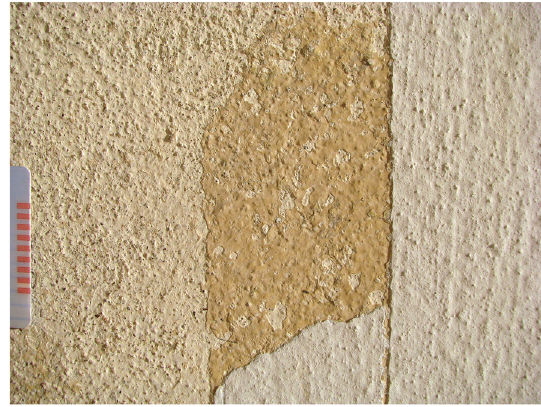
Fig. 9 Tugendhat House, Brno, 1930, view to the southeast, detail: probe during the removal of the later plasterings (from right to left): painting of 1985 (with cement and synthetic resin), two lime coats (between 1945 and 1965), heavily sulfated due to air pollution, and original surface with yellowish whitewash (picture lower edge approx. 17 cm) (Source: Ivo Hammer